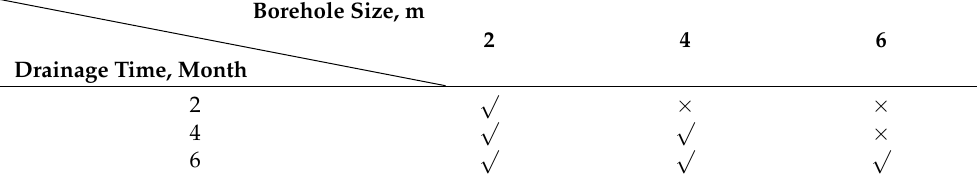
Table 6. Gas drainage performance of different drainage conditions *.